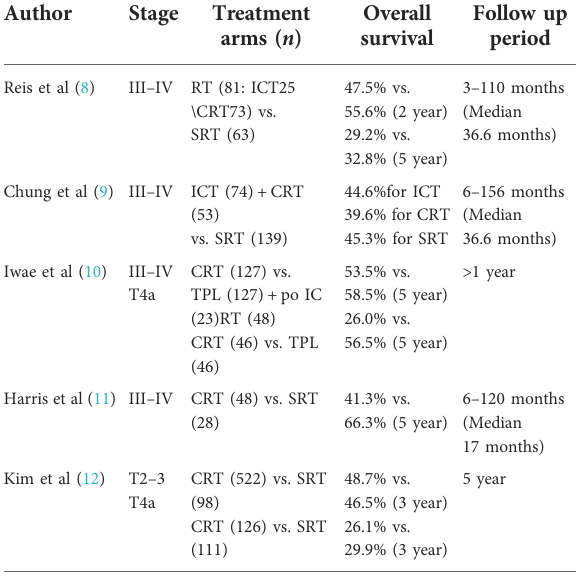
TABLE 5 Summary of literature on surgical and non-operative treatments of advanced hypopharyngeal carcinoma in the past 5